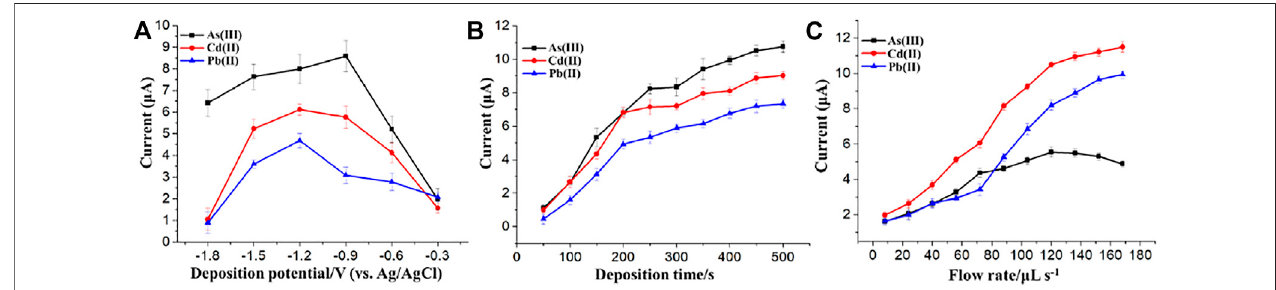
Frontiers in Chemistry |